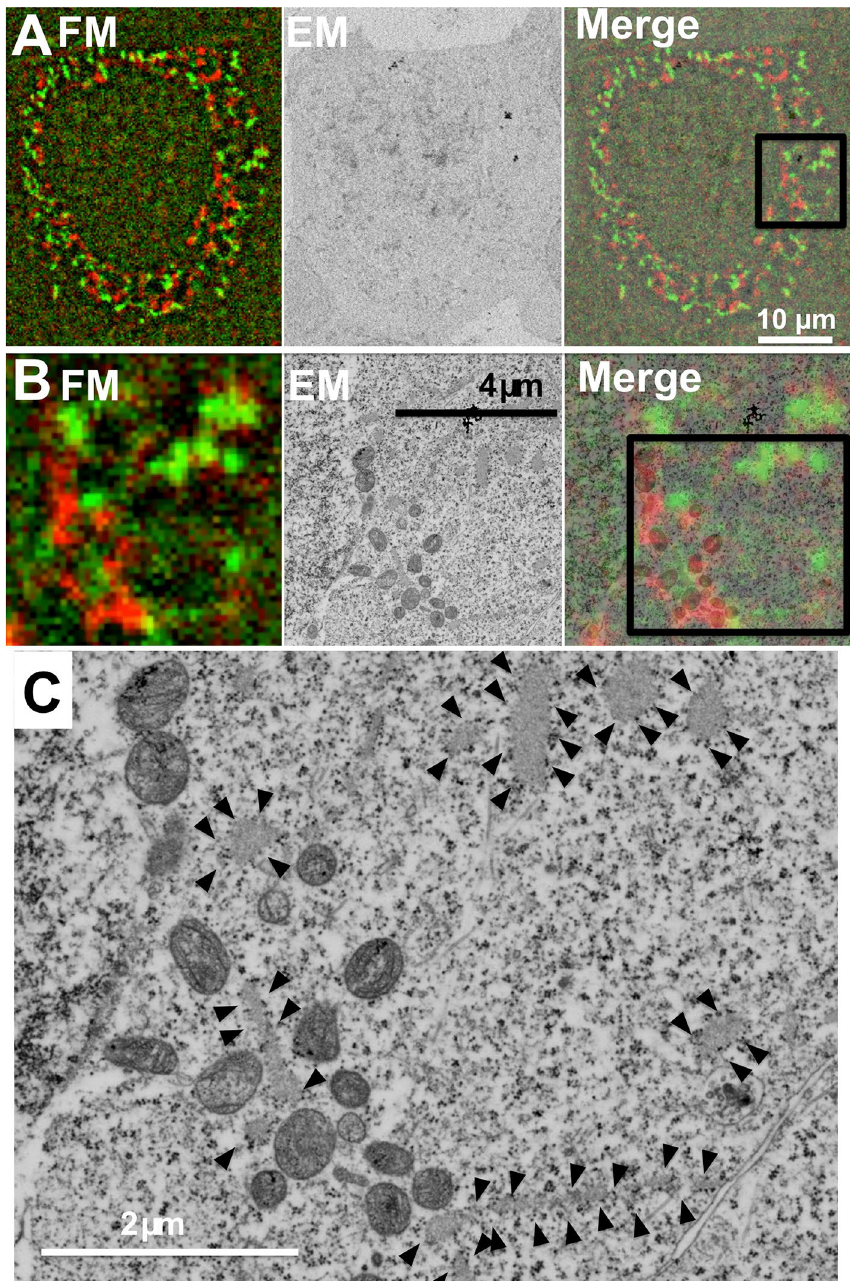
Figure 4. Two-color in-resin CLEM of nucleus and endoplasmic reticulum was performed using mWasabi-ER and mCherry2-mito. Thin section (100 nm) of Epon-embedded cells expressing mWasabi-ER (green pseudo color) and mCherry2-mito (red pseudo color) was prepared. Fluorescent images (FM) and electron microscopic images (EM) were obtained as described in Fig. 2. The “Merge” images in ( A ) and ( B ) are merged images of a fluorescence image of FM and EM. The images in ( B ) indicate magnification of images corresponding to the boxed area in the Merge image in ( A ). The EM images in ( C ) indicate magnification of image corresponding to the boxed area in the Merge image in ( B ). Arrowheads in ( C ) indicate green fluorescence-positive rough endoplasmic